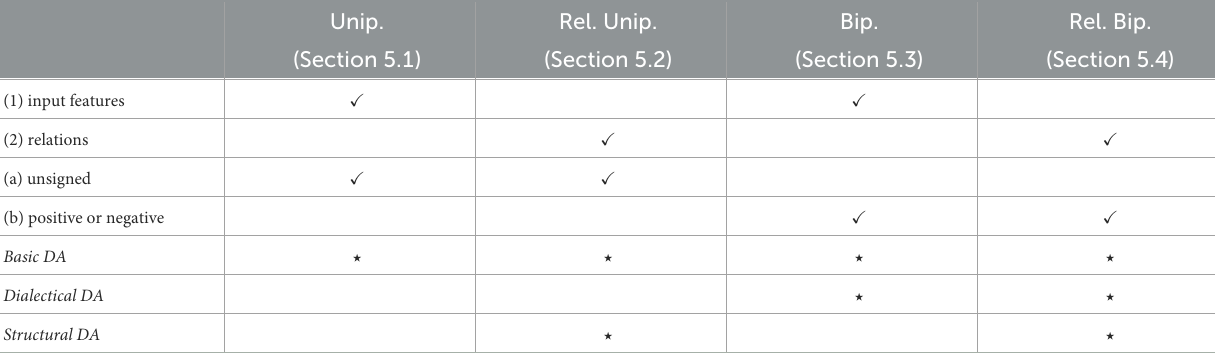
TABLE 3 Explanations with the characteristics they hold (as combinations of (1)-(2) and (a)-(b)) represented by X and their DA properties (in italics) represented by ⋆